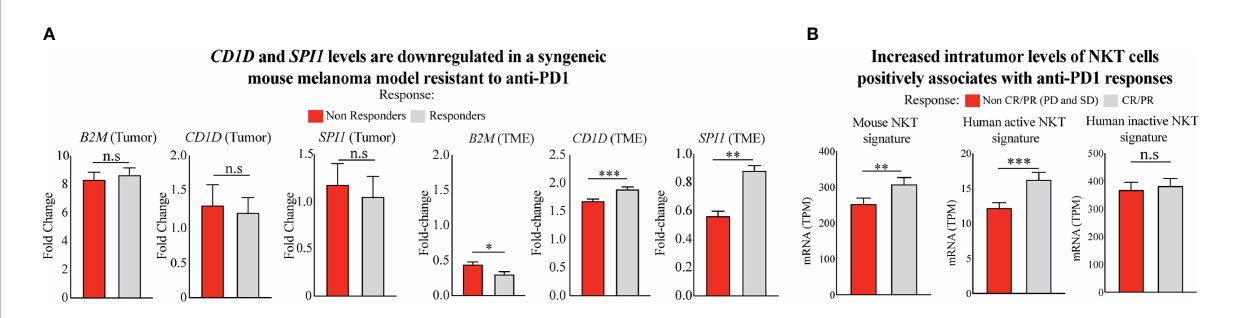
FIGURE 3 Poor response to ICT given is associated with reduced levels of intratumor NKT cells. (A) Comparison of gene expression of CD1D ( CD1d1 in mouse) and SPI1 in the TME of anti-PD1 responsive and non-responsive mouse models (44). Two-tailed, unpaired t -test (*** p < 0.0001; ** p < 0.001; * p < 0.05; n.s., not signi fi cant). (B) Comparison of NKT cell levels using multigene NKT signature validated pairwise by the mouse model in bulk and single-cell datasets (45) and human active (stimulated) and inactive (unstimulated) NKT cell signature (46). Differential signature expression is shown between metastatic melanoma patients responding and not responding to anti-PD1 therapy. Patient samples were included from the integrated cohort of human melanoma patients receiving mainly anti-PD1 immunotherapies (23 – 26). Responders and non-responders to ICT were strati fi ed using RECIST V1.1 (47) and iRECIST (48) criteria. Two-tailed, unpaired t -test (*** p < 0.0001; ** p< 0.001; n.s., not signi fi